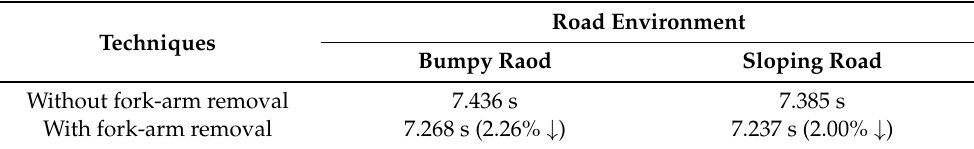
Table 6. Efficiency of a 14-DOF vehicle model with and without the fork-arm removal technique in 20 s